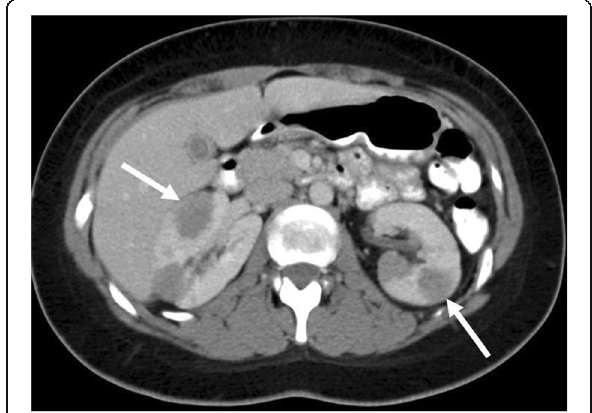
Fig. 5 Renal involvement with renal masses. Contrast-enhanced axial CT image of a 23-year-old female with known Burkitt lymphoma demonstrates multiple circumscribed hypoattenuating renal masses (arrows)